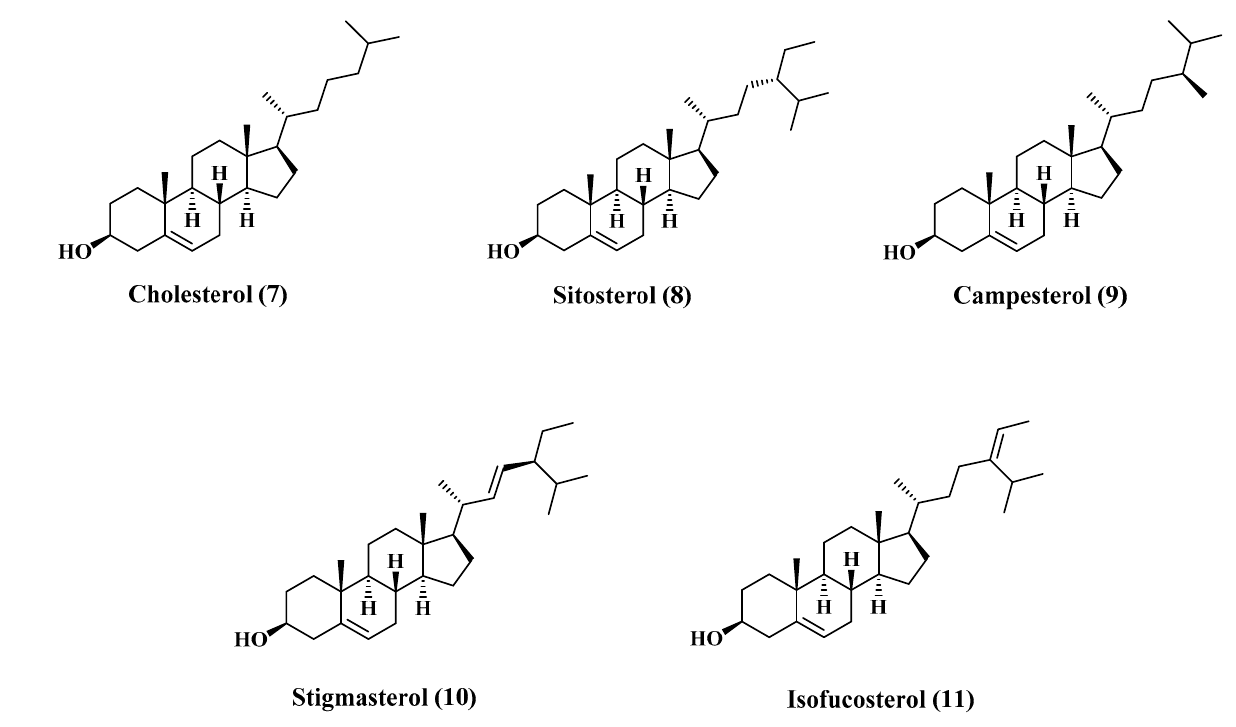
Figure 2. Structures of major sterols content of jojoba oil. Table 3. The average percentage of sterols content in jojoba oil.